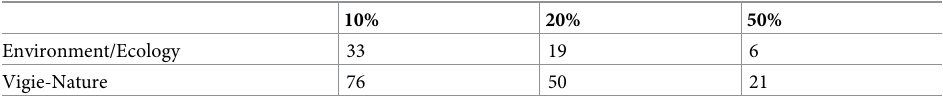
Table 2. Citation thresholds for the 10%, 20% and 50% most cited papers, for Vigie-Nature and the whole Envi- ronment and Ecology field, between 2009 and 2019.